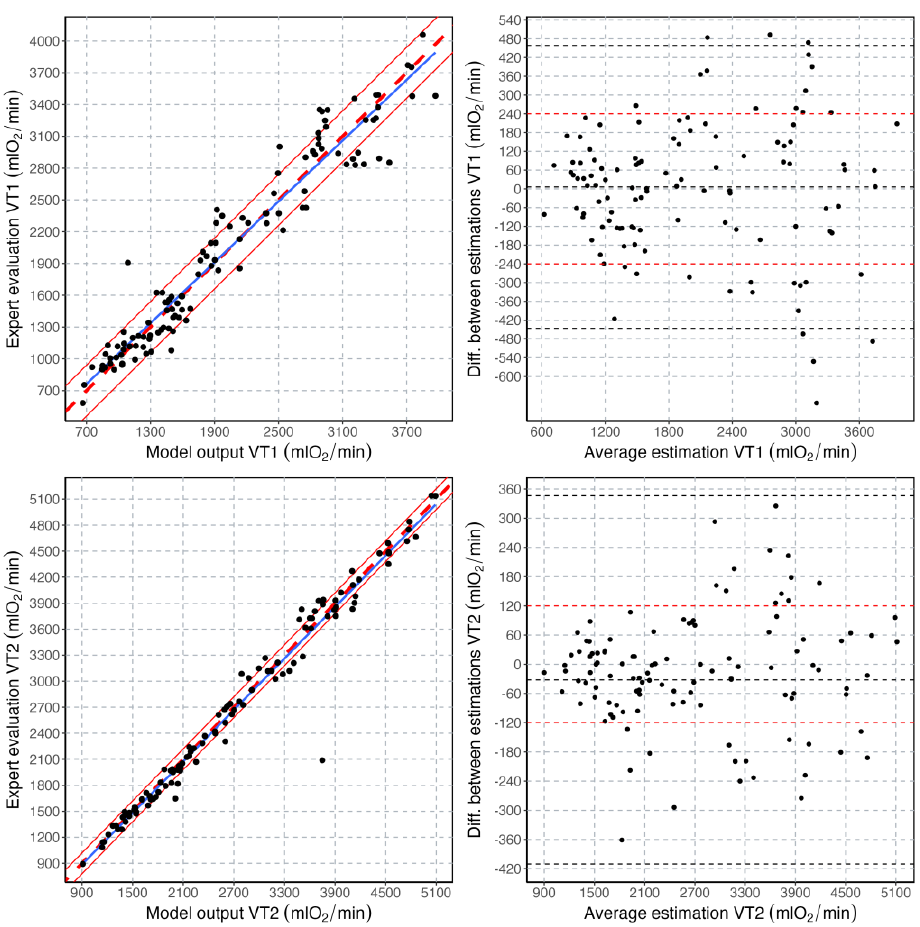
Figure 3. Correlation plots and Bland-Altman plots for the exercise threshold values estimated with the machine learning model and those estimated by the experts. In the correlation plots, the blue line is the regression line, the thick dashed red line is the line with a slope of 1, and the thin continuous lines indicate the ±240 and ±120 mlO 2 ranges for VT1 and VT2, respectively. In the Bland-Altman plots, the average value and the limits of agreement are indicated with a dashed black line. The ±240 and ±120 mlO 2 ranges are also highlighted by horizontal dashed red lines for VT1 and VT2, respectively.